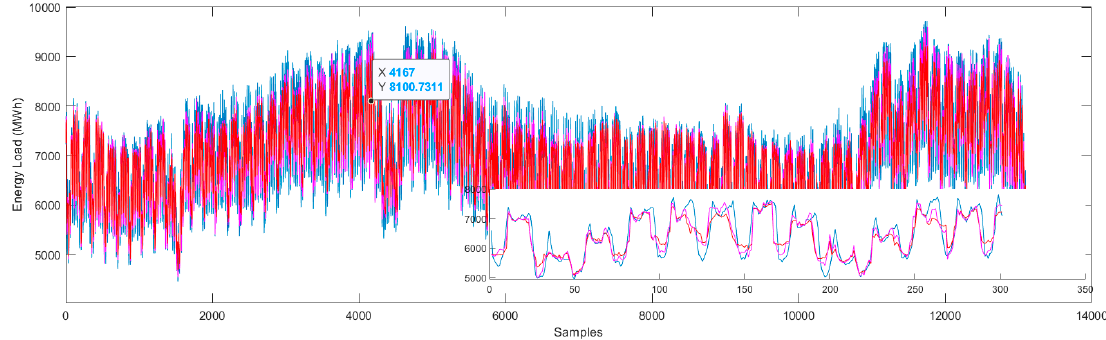
Figure 9. Comparison between historical data, predicted value, and forecasting value with error prediction.